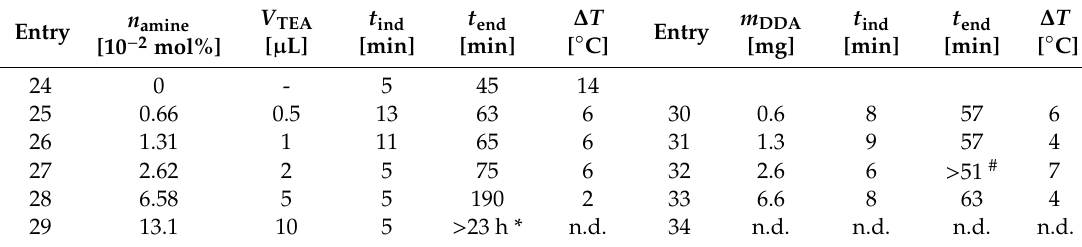
Figure 7. Pressure curves of activation procedure with triethyl amine (TEA) ( a ) and dodecyl amine (DDA) ( b ). Table 7. Catalyst activation in the presence of